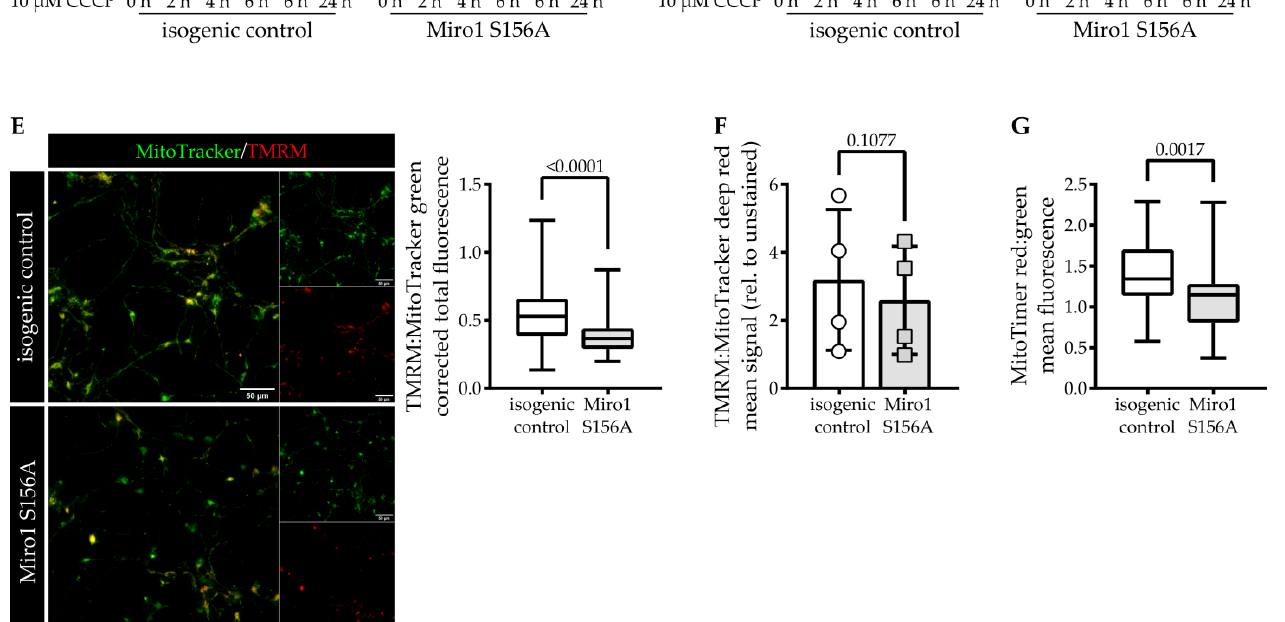
Figure 2. Miro1 degradation is impaired in Miro1 S156A hDaNs. ( A ) Representative Western blot showing Miro1, Mitofusin, and LC3 in hDaN lysate. Neurons were treated with a final concentration of 10 µM CCCP for 0, 2, 4, 6 ( 10 µM MG132), or 24 h to induce mitophagy. ( B ) Quantification of intensity of Miro1 Western blot bands normalized to α-vinculin. Error bars depict SD (n Diff = 3); Friedman’s test with Dunn’s multiple comparisons relative to 0 h of the respective genotype. ( C ) Quantification of the intensity of Mitofusin Western blot bands normalized to α-vinculin. Error bars depict SD (n Diff = 3); Friedman’s test with Dunn’s multiple comparisons relative to 0 h of the respective genotype. ( D ) Ratio of LC3II:LC3I quantification of the intensity of LC3 Western blot bands normalized to α-vinculin. Error bars depict SD (n Diff = 3); 2way ANOVA with Tukey’s multiple comparisons. ( E ) Imaging analysis of mitochondrial membrane potential in hDaNs stained with 25 nM TMRM and 100 nM MitoTracker green. Representative live cell image of TMRM and MitoTracker green staining. Quantification of corrected total fluorescence of TMRM relative to MitoTracker green. Error bars depict SD (n Diff = 3); Mann-Whitney test. ( F ) Flow cytometric measurement of mitochondrial membrane potential in hDaNs stained with 100 nM TMRM and 100 nM MitoTracker